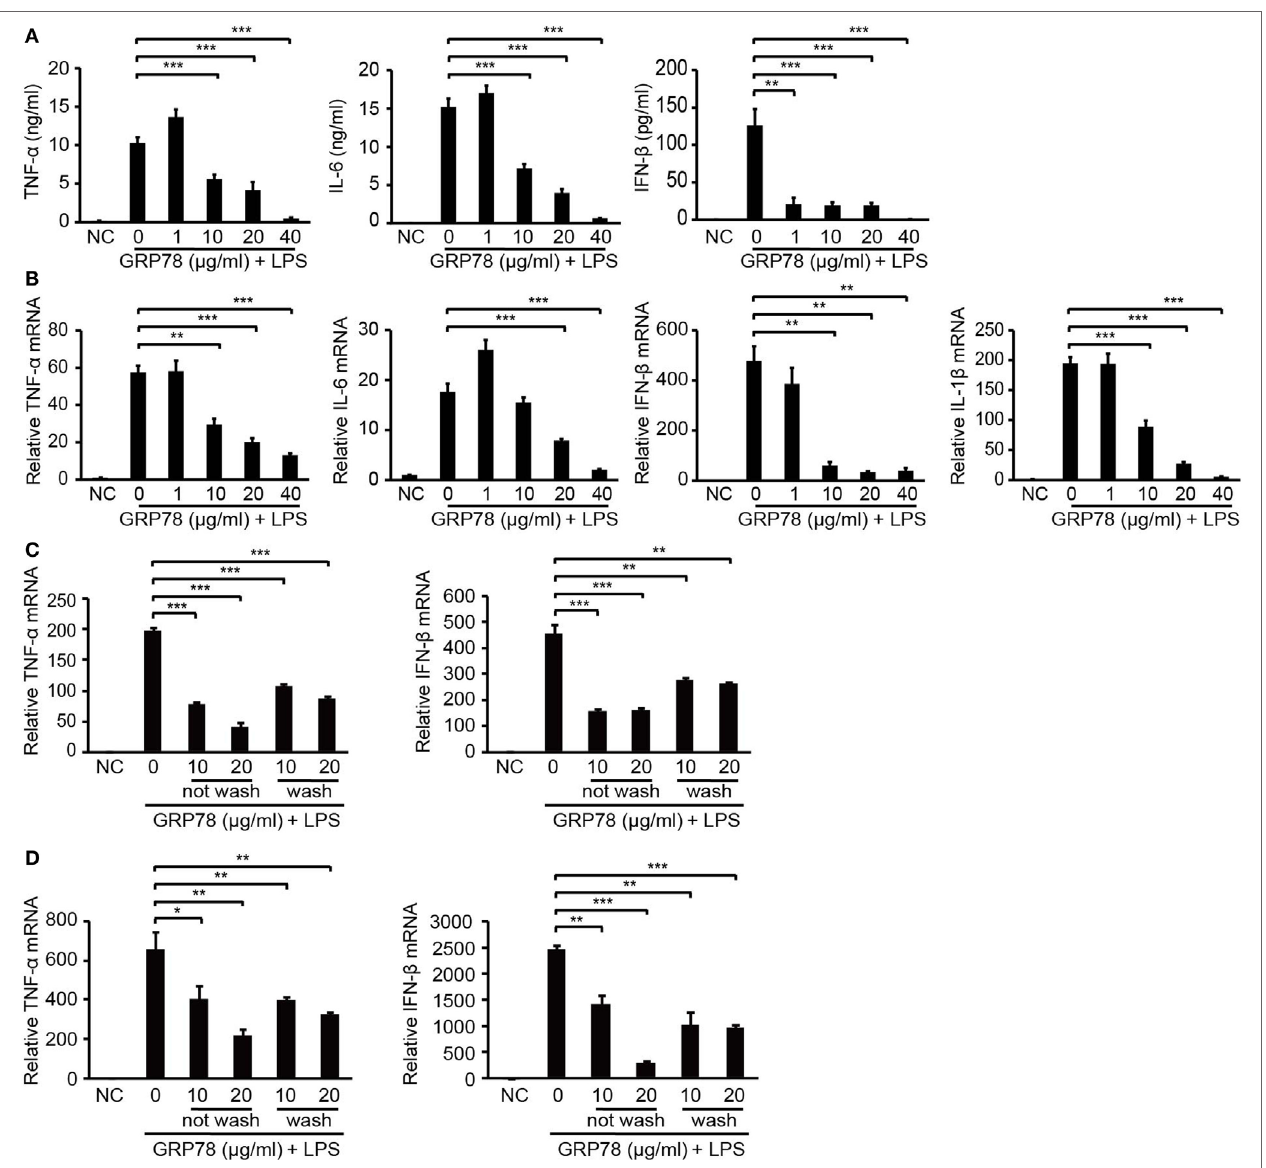
FigUre 1 | grP78 inhibits production of lipopolysaccharide (lPs)-induced cytokines in bone marrow-derived dendritic cells (BMDcs) and bone marrow-derived macrophages (BMDMs) . Enzyme-linked immunosorbent assay (a) and real-time quantitative polymerase chain reaction (qRT-PCR) (B) of tumor necrosis factor (TNF)- α , interleukin (IL)-1 β , IL-6, and interferon (IFN)- β in murine BMDCs unstimulated (NC) or stimulated for 4 h (a) or 2 h (B) by LPS (100 ng/mL) and simultaneously by GRP78 at the concentrations indicated. qRT-PCR of TNF- α and IFN- β in BMDCs (c) or BMDMs (D) which were treated with GRP78 (10 or 20 µg/mL) for 2 h, then were washed thrice with culture medium (wash) or not (not wash), followed by 100 ng/mL LPS for 2 h. Error bars represent mean ± SD from triplicate samples in one experiment. * P < 0.05, ** P < 0.01, and *** P <